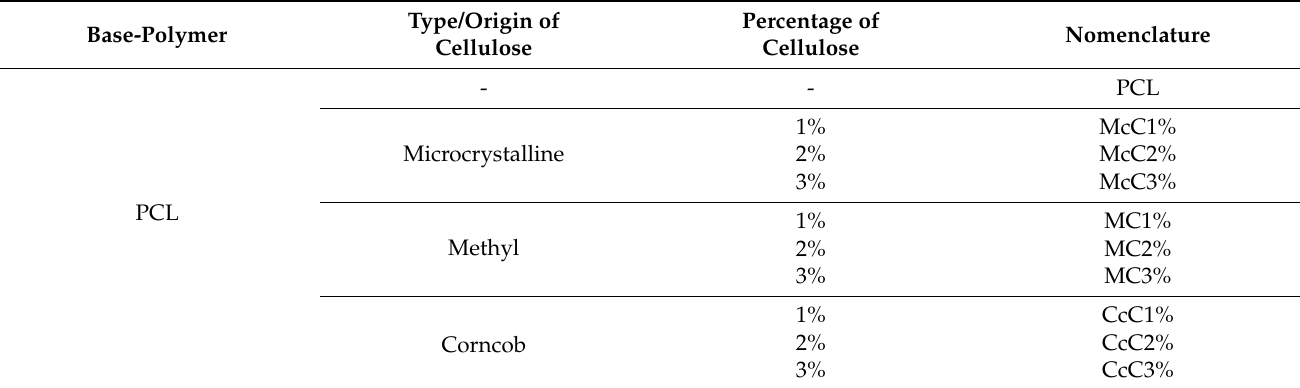
Table 1. Nomenclature used for the different PCL and cellulose (microcrystalline, methyl-, and corncob) samples, with respective percentage and type of